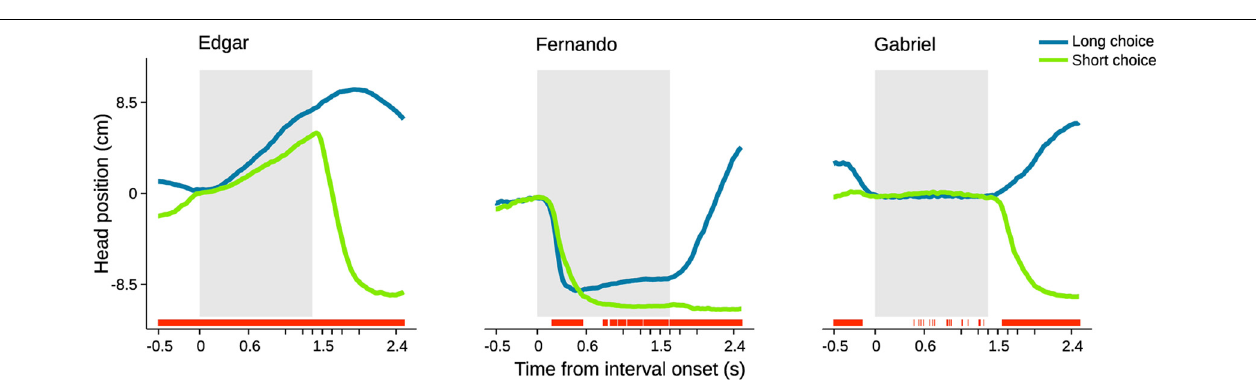
near-boundary stimulus interval ( I = 1 . 38s). Short choice trials were put on the green, and long choice trials on the red channel. Times when frames were taken are indicated in seconds relative to interval onset.